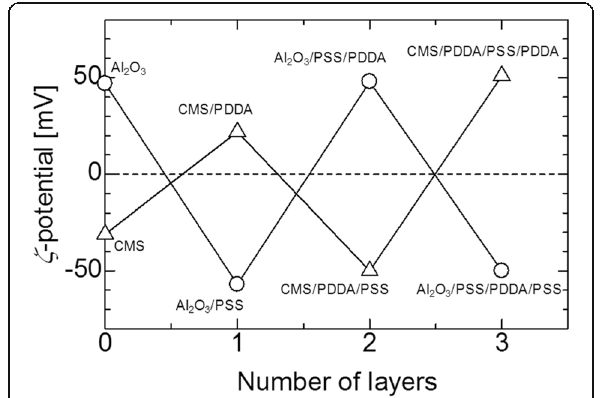
Fig. 1 Zeta potential of surface charge-controlled Al 2 O 3 and carbon